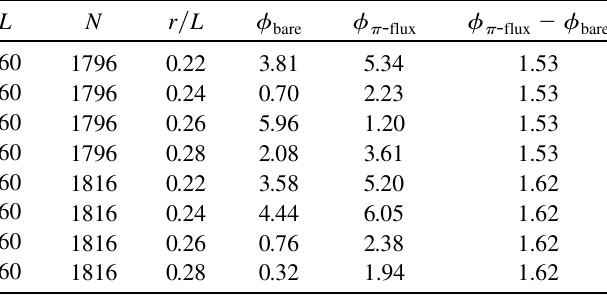
TABLE II. Berry phases for taking a vortex around a local flux (cid:5) . The results show good agreement with the theoretical pre- (cid:1) (cid:6) ¼ (cid:5)= 2 . For each system size, we have diction of (cid:6) (cid:5) - flux bare two different values of the number of particles N . We have q ¼